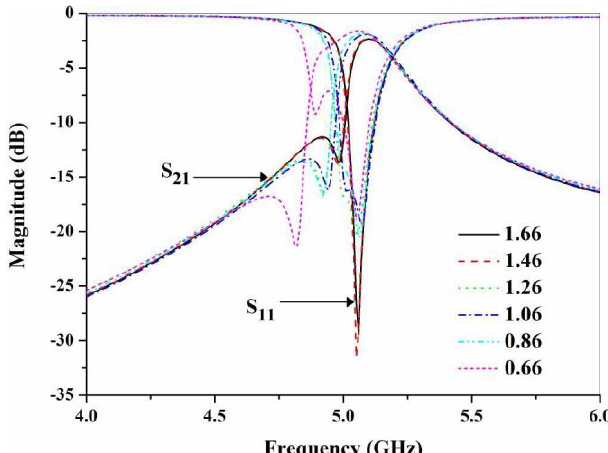
Figure 8: Simulation results for various positions (slot_pos) of vertical slot for a slot length (slot_ver) of 5.7